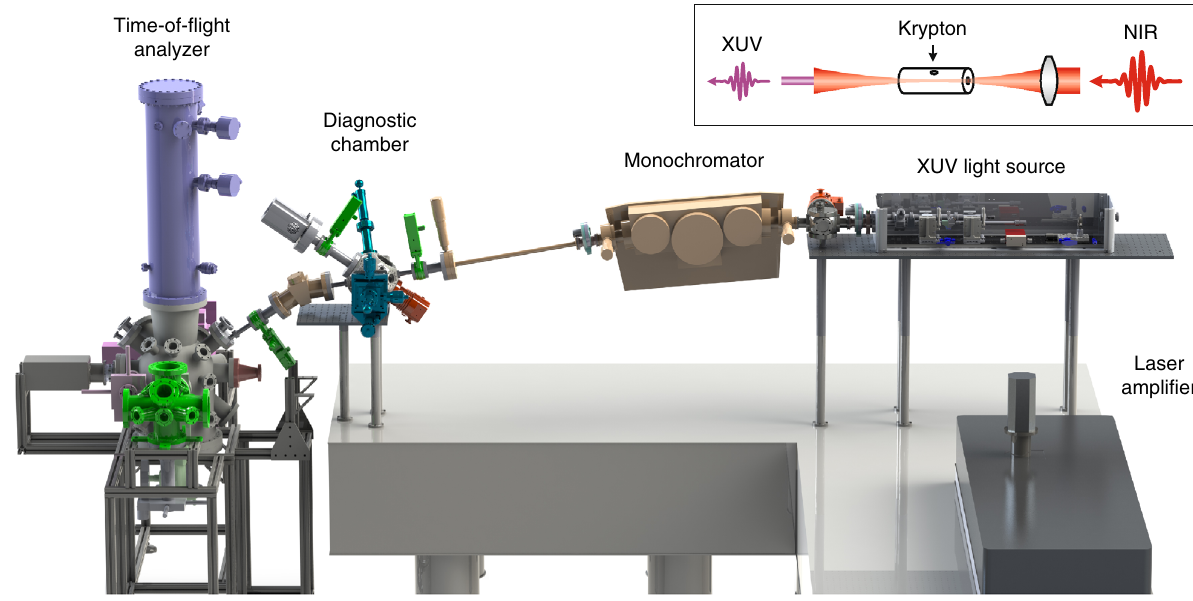
Fig. 1 XUV-based time-resolved ARPES setup overview. Inset (top-right) shows the experimental layout for high harmonic generation (HHG) of a near infrared (NIR) light through a hollow fi ber fi lled with krypton gas to generate extreme ultraviolet (XUV)